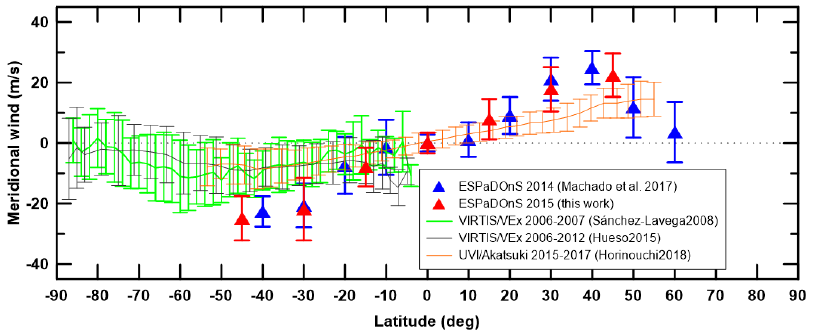
Figure 8. Long term comparison of meridional wind latitudinal profiles obtained from several obser- vations. The comparison includes results from Doppler velocimetry observations using ESpaDOn- S/CFHT from 2014 [10]), cloud-tracked observations using VIRTIS-M/VEx from 2006–2012 [7,9] and UVI/Akatsuki from 2015–2017